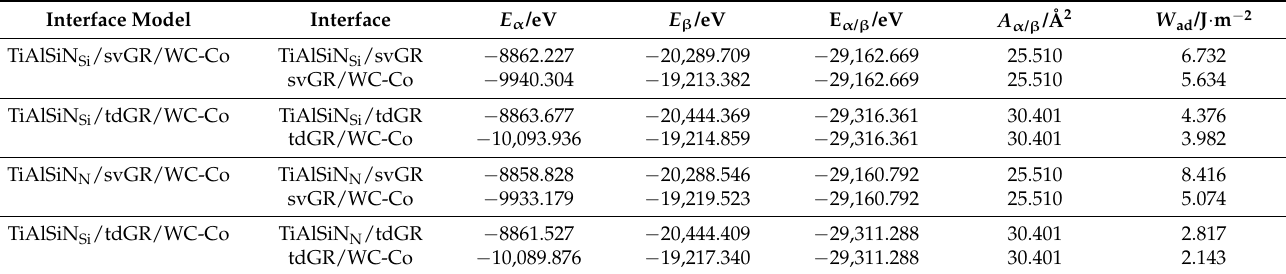
Table 7. Adhesion works of coating/matrix interface doped with defective